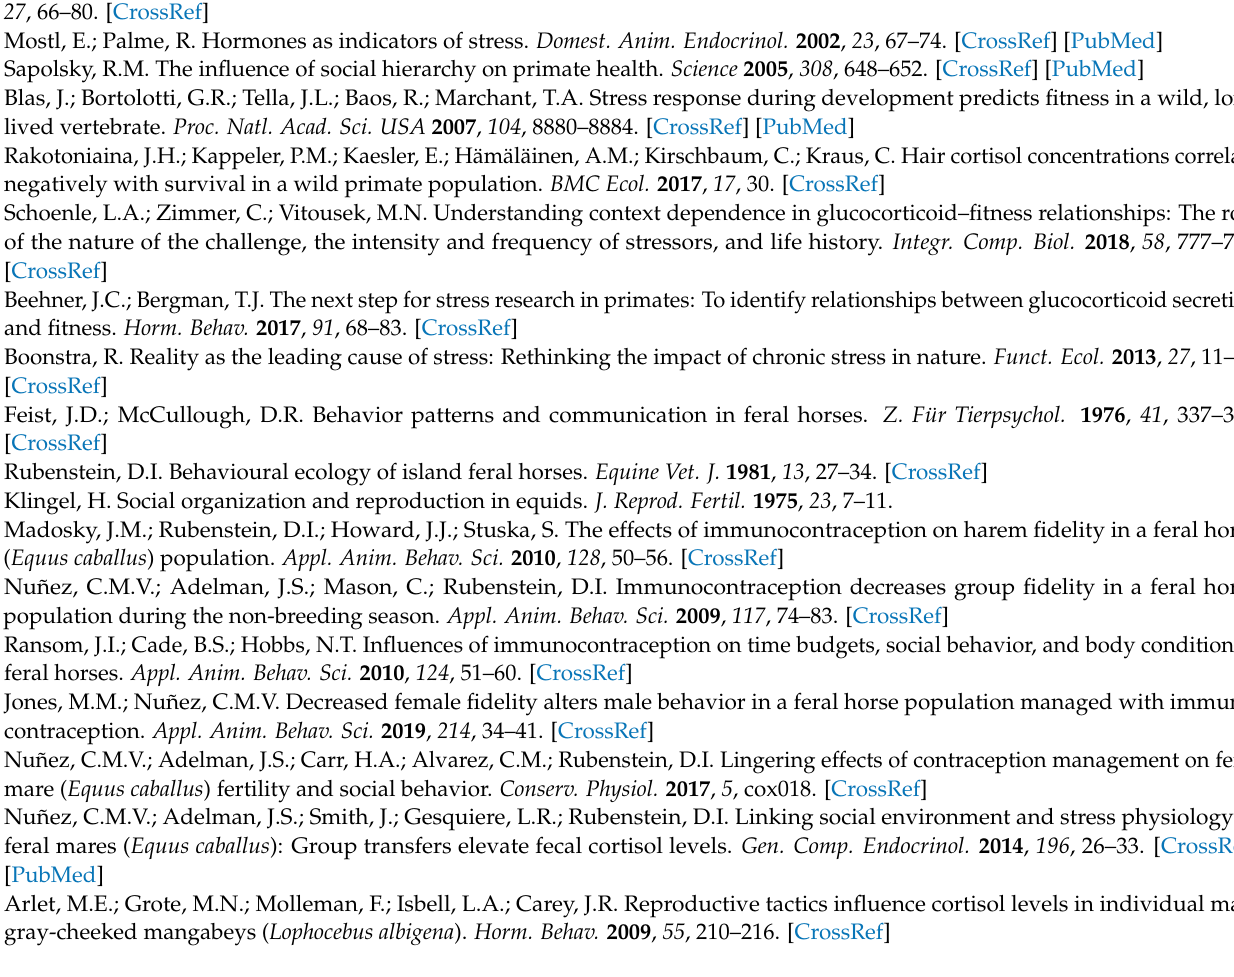
Figure A1. The number of group changes stallions experienced (raw data) and stallion FCM concentrations. FCM concentrations did not vary with the number of group changes males experienced. Open circles indicate individual fecal samples; dotted line indicates model predictions.